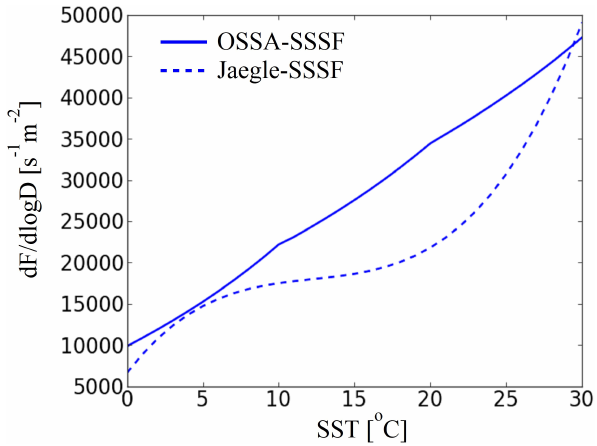
Fig. 12. Comparison of the effect of sea surface temperature (SST) on the particle production for using the OSSA-SSSF and the formu- lation by Jaeglé et al. (2011) for D p =1µm particles at 9ms − 1 wind speed. To eliminate the effect of the wave state, which was incorpo- rated into the OSSA-SSSF, the constant values of C d =1.3 × 10 − 3 and H s =1.5 were used in the calculation of the production